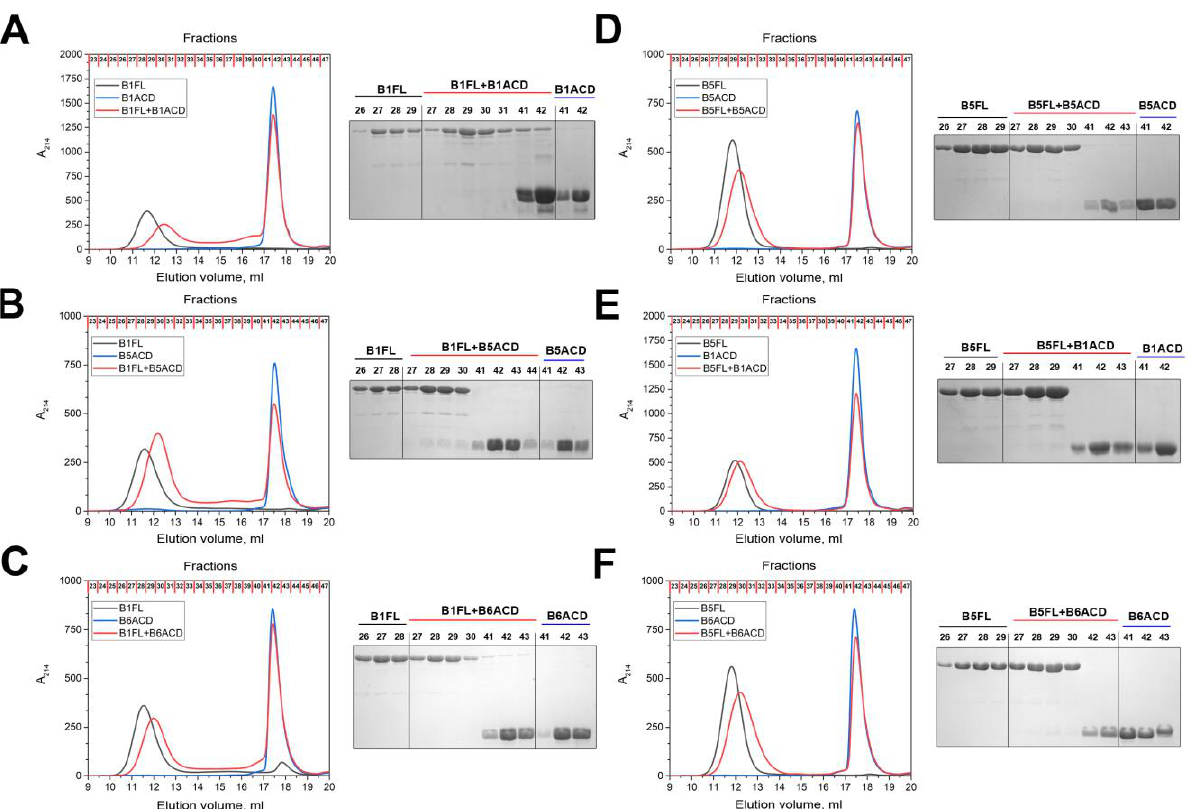
Figure 4. Interaction of selected ACDs with large oligomers of ( A – C ) HspB1 and ( D – F ) HspB5. Elution profiles of isolated full-length (FL) small heat shock proteins (black lines), isolated ACDs (blue lines) and their mixtures (red lines) on a Superdex 200 Increase 30/100 column. The protein composition of the fractions collected during each elution profile (no less than three runs) and analyzed by SDS – PAGE on the right-hand panel of each elution profile are presented.